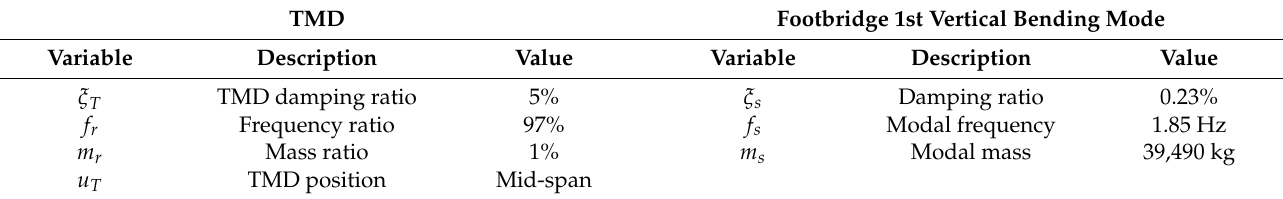
Table 2. TMD design and structure modal